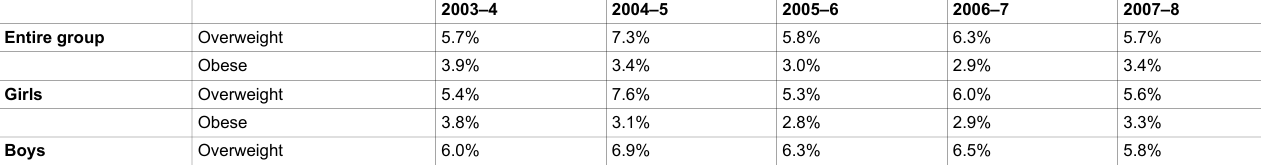
Table 4 Distribution of prevalence using Kromeyer’s references for the entire group and divided into gender